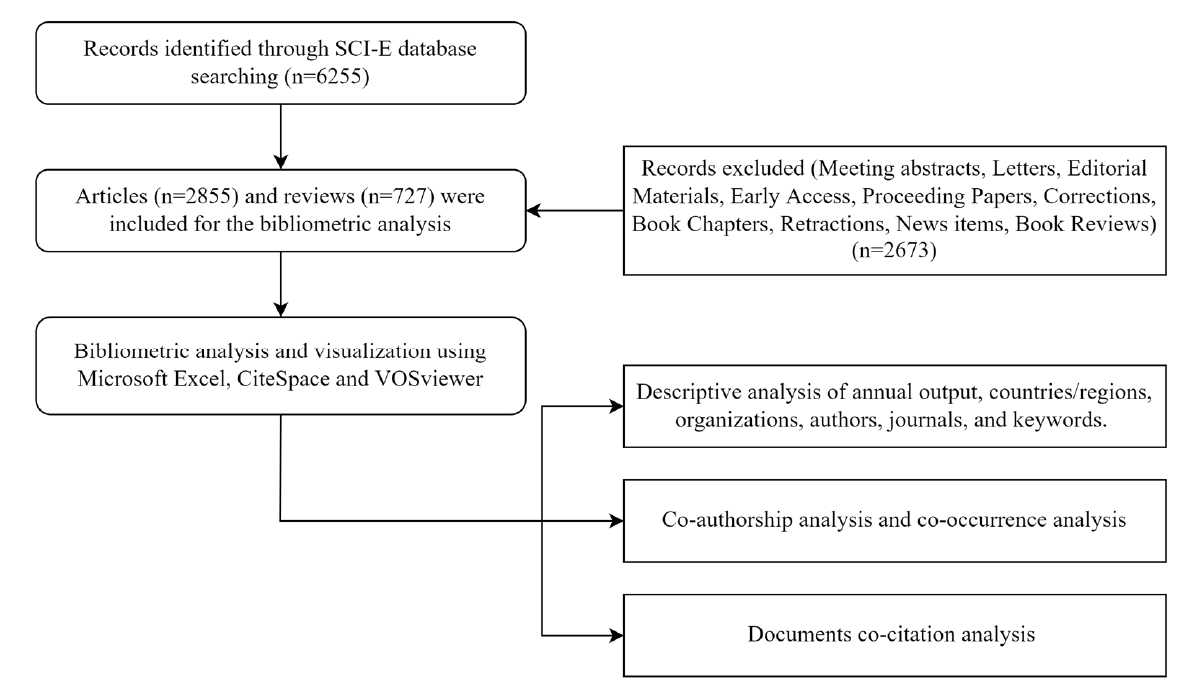
Figure 1. Flow diagram of the literature search, selection, and analysis process.